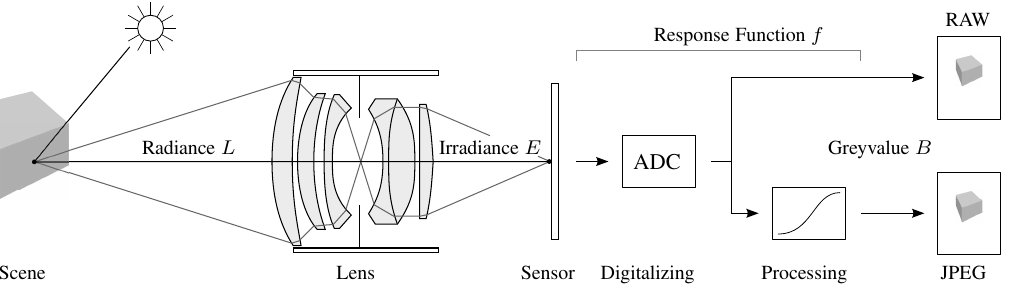
Figure 2. simplified model of radiometric image formation